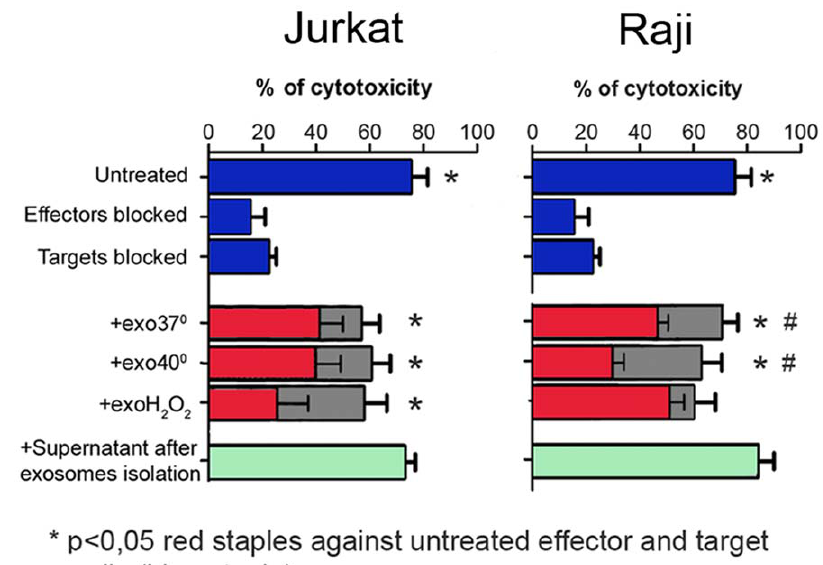
Figure 5. Stress enhances the immunosuppressive effect of NKG2DL-bearing exosomes. NK-cell cytotoxicity assay using PBMC from healthy donors and K562 targets at an E:T ratio 40:1. The cytotoxic effect was measured in the presence or absence of exosomes released from cells cultured under steady state or stressed conditions. The cytotoxic response of untreated or antibody-blocked effector and target cells are shown in blue staples. The suppression of cytotoxicity by native exosomes released from cells cultured in various conditions is shown in red staples. Gray staples underlayed under the red staples show reversal of cytotoxicity to normal levels when the exosomes were blocked with a cocktail of Abs against NKG2DL or with Abs against the exosomal marker CD63. Green staple shows the level of cytotoxicity in the presence of used supernatant after exosome isolation indicating that the suppressive effect was associated with the exosomal fraction. * and # indicates statistical significance, p ,